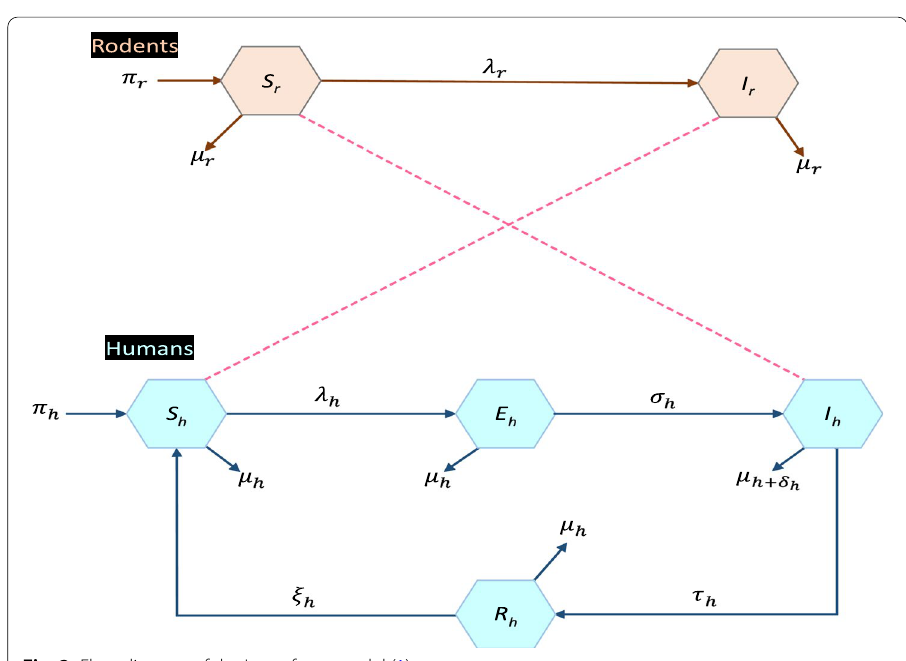
Fig. 2 Flow diagram of the Lassa fever model (1)